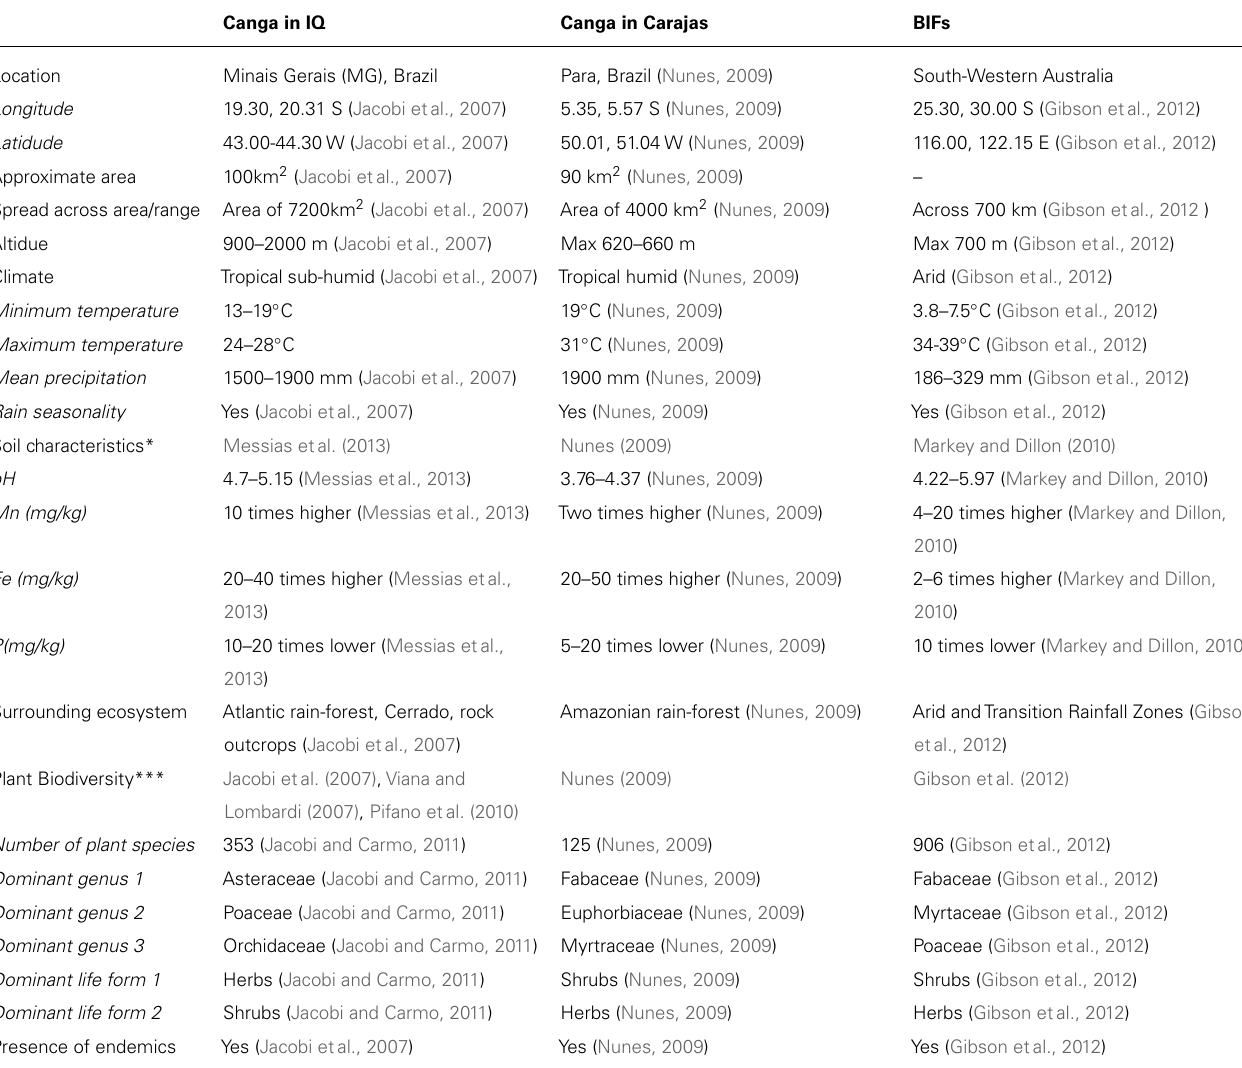
Table 1 | Comparison of iron based ecosystems in Brasil (canga) andAustralia (bounded iron formations). Canga in IQ Canga in